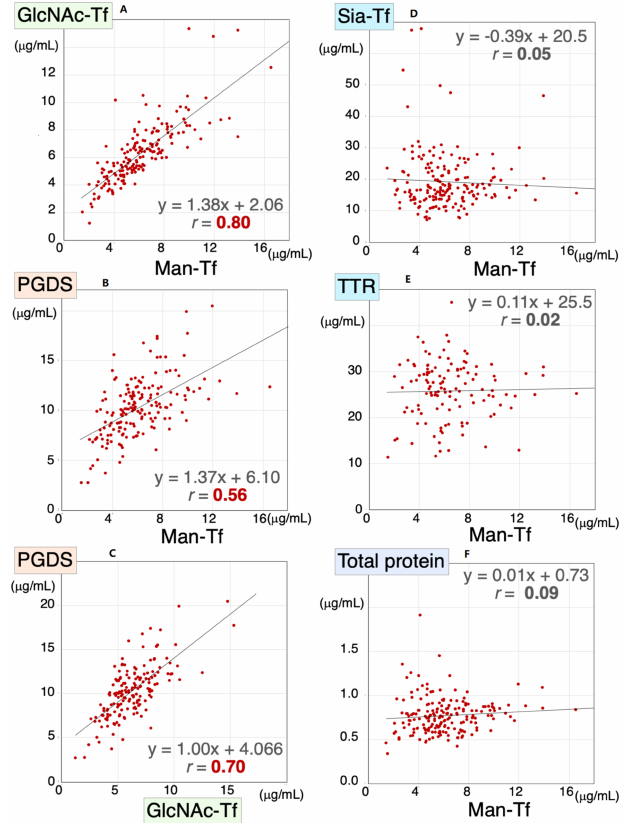
Figure 3. Scatter diagrams for Man-Tf and other CSF proteins for all subjects included in the present study. Correlation coefficients and regression line equations for Man-Tf versus GlcNAc-Tf, L-PGDS, TTR, Sia-Tf and total protein are shown. Data for TTR levels in PD were not determined. Man-Tf data, except for CN subjects, are cited from our previous paper, reprinted with permission from ref. [15], 2021, Yasuhiro